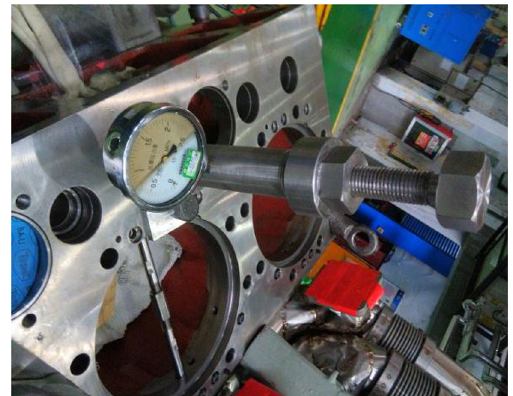
Figure 9. Cylinder hole of the